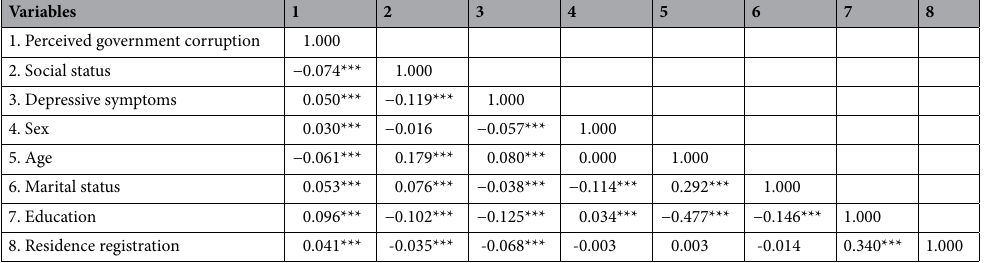
Table 3. Correlation among variables (N = 14,116). ***p < 0.001, **p < 0.01, *p < 0.05.